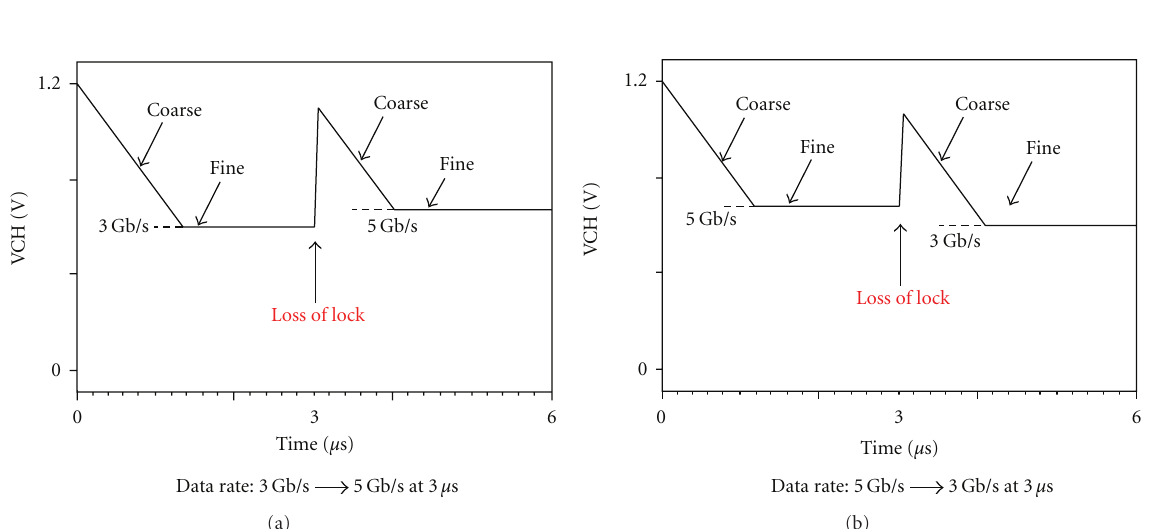
Figure 5: Cases of loss of lock.